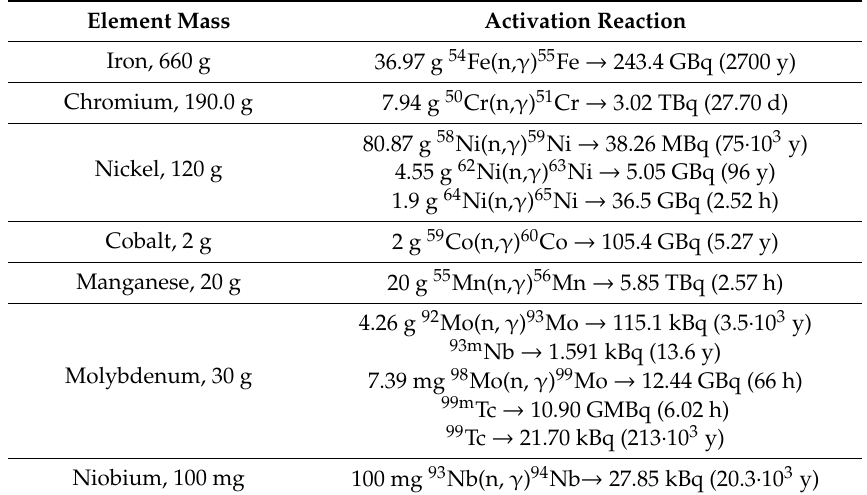
Table 3. Activating 1 kg of SS304L with slow and thermal neutrons, after turning o ff the beam.